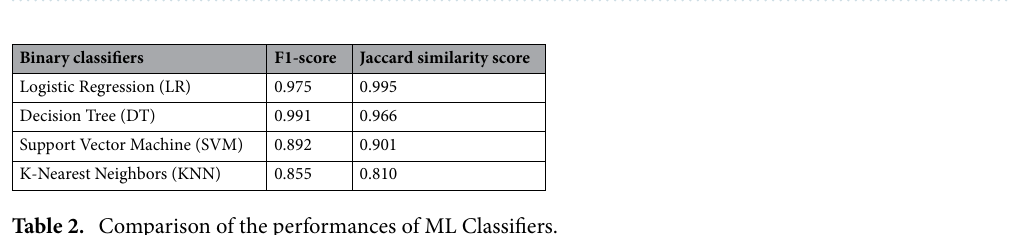
Figure 7. Flooded locations detected by the DT model for representative scenarios with upstream discharge values ( a ) 52 and ( b ) 99 cms. Prediction performance of the DT algorithm is the best among all other classifiers. Maps are processed and generated in the ArcGIS Pro platform 81 .